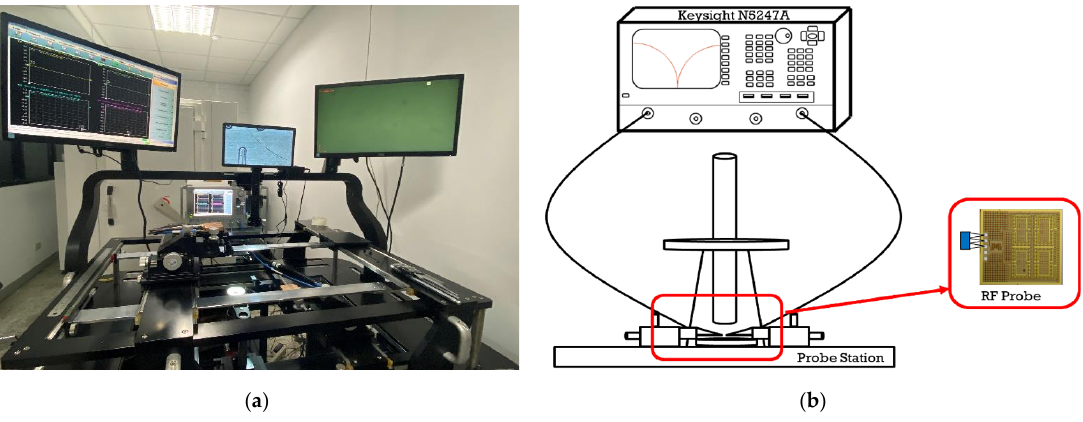
Figure 21. ( a ) Measurement system. ( b ) Measurement schematic.